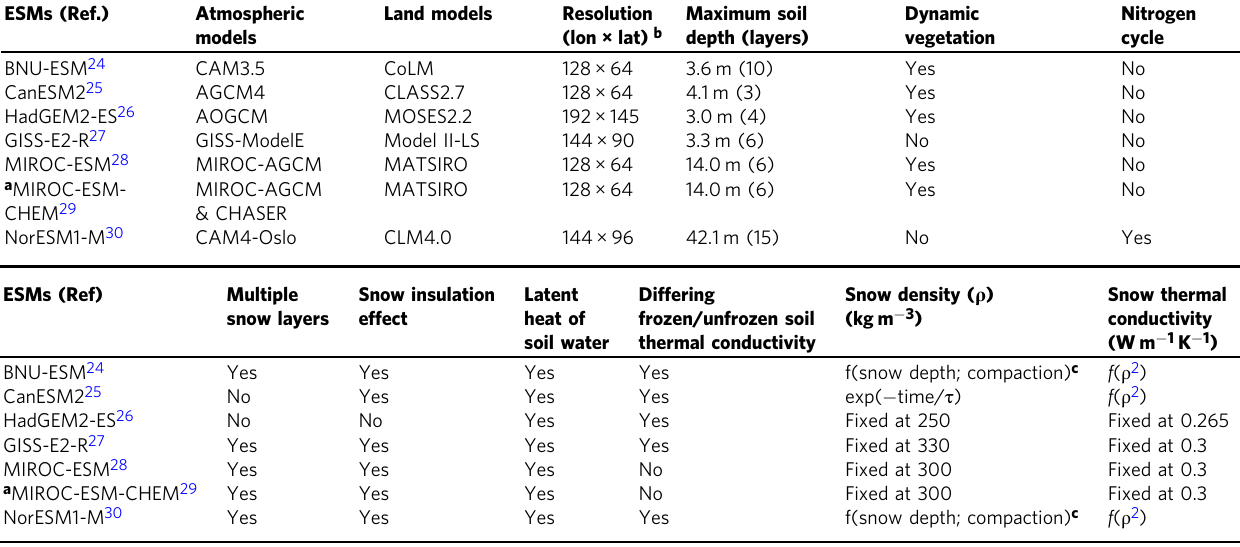
Table 1 The models used in this study and their attributes. ESMs